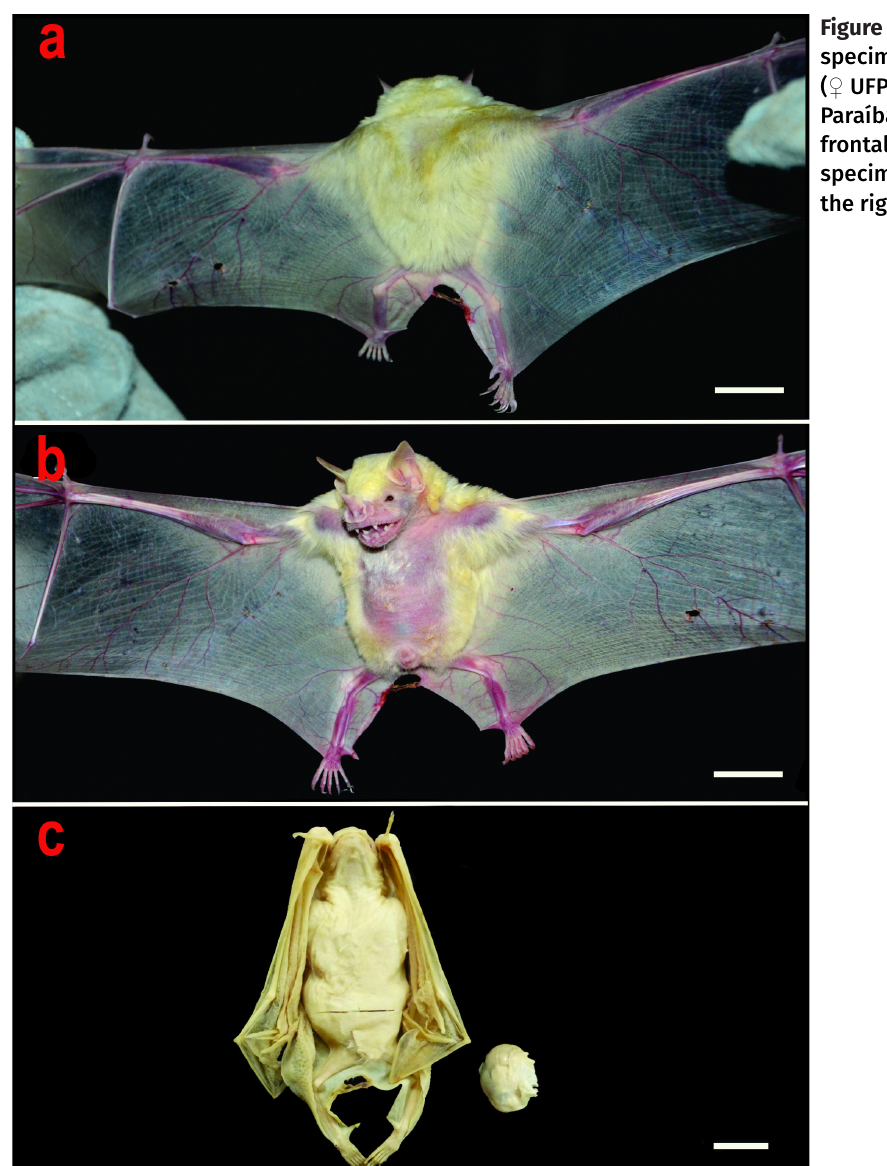
Figure 1. Pregnant albino specimen of Artibeus planirostris ( ♀ UFPE 3709) captured in Paraíba, Brazil: dorsal (a) and frontal (b) perspectives, and the specimen with its male fetus on the right side (c).